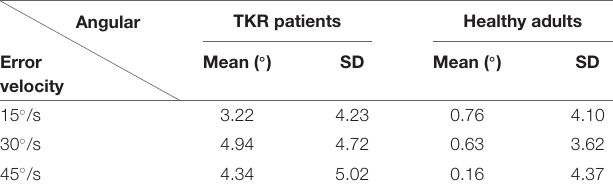
TABLE 2 | The mean and standard deviation (SD) of the difference between IMU sensors and BTE Primus RS estimation results.